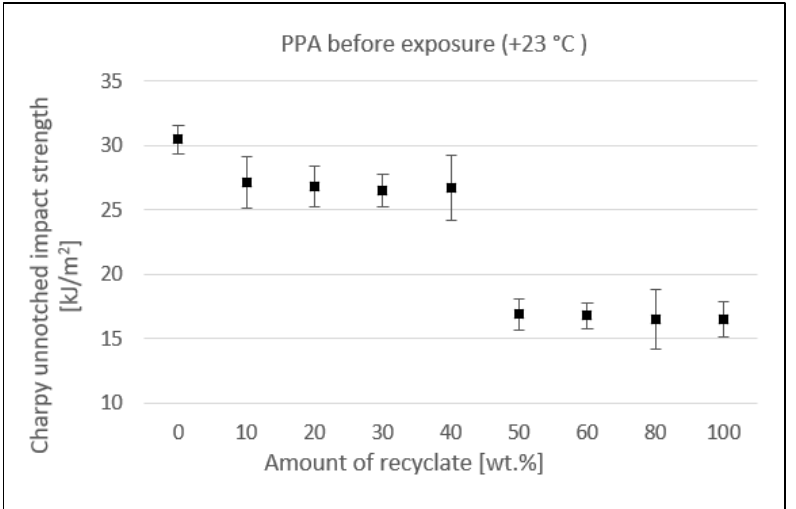
Figure 6. Dependence of the unnotched impact strength of PPA on the amount of recycled material before the samples were exposed to elevated temperature (+23 °C).